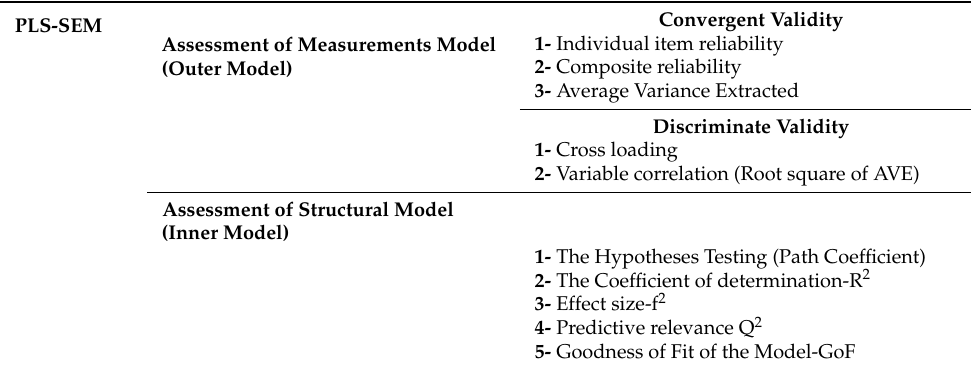
Table 3. PLS-SEM analysis steps